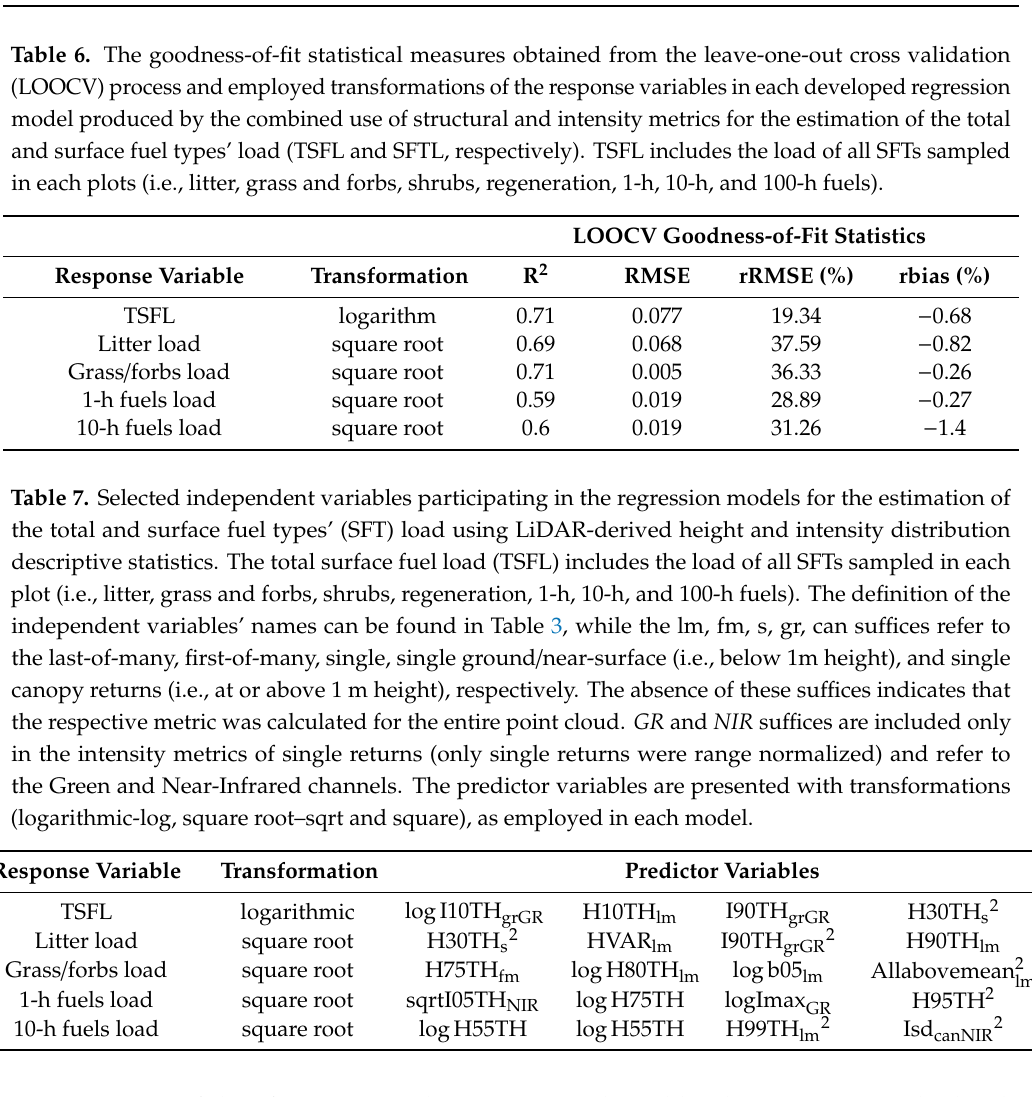
1:1 relationship (Figure 4). Regarding the residual distributions presented in Figure 5, a fair homogeneity can be observed without displaying any strong distribution patterns or obvious systematic